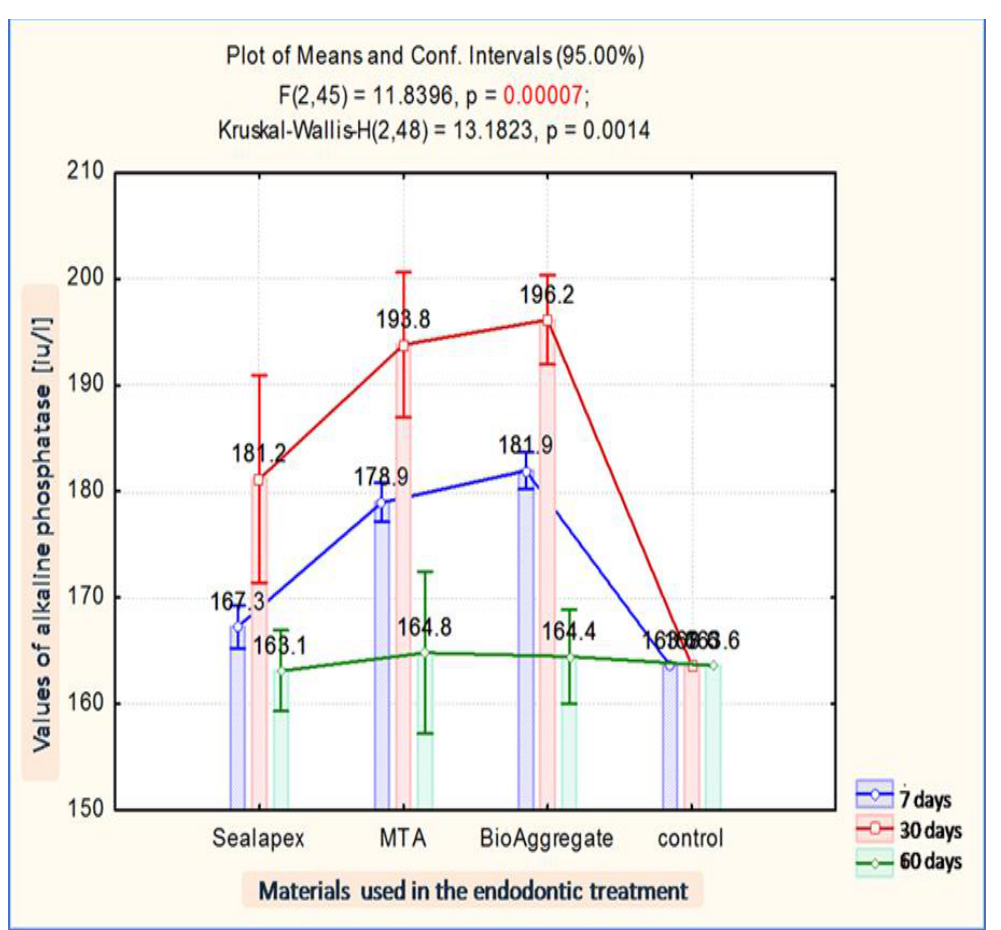
Figure 12. Statistical indicators of alkaline phosphatase according to the assessing moment and material used.